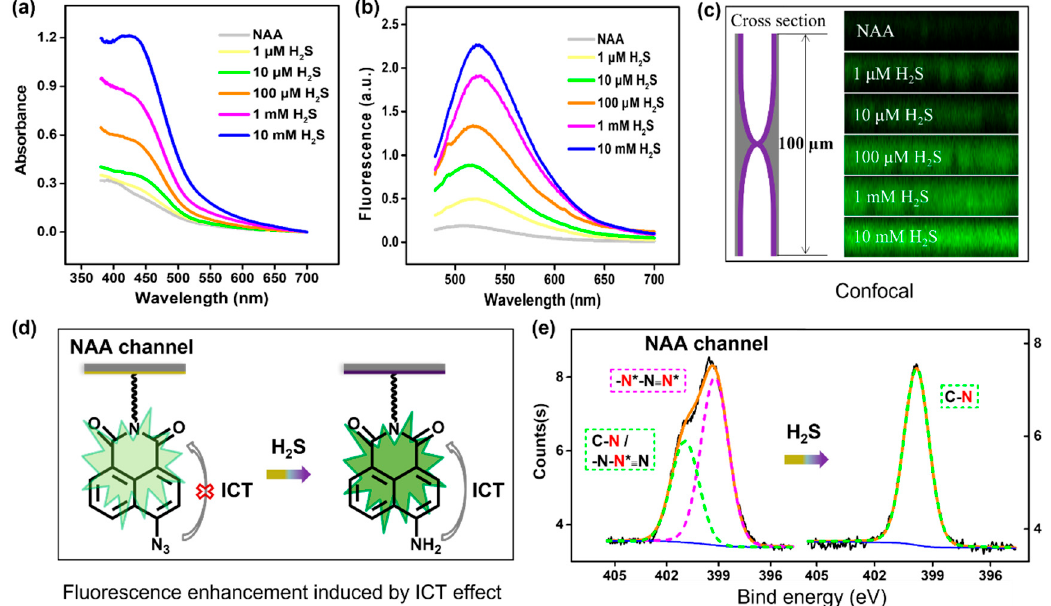
Figure 3. Optical responses of functionalized NAA-modified nanochannels towards H 2 S. ( a ) absorption spectra, ( b ) fluorescence spectra, and ( c ) LSCM images of the nanochannels upon incremental H 2 S concentration. The diagram on the left represents the cross-section of a typical single channel with 100 µm thickness. ( d ) ICT mechanism of NAA probe based on azide reduction by H 2 S. Green fluorescence was recovered upon H 2 S exposure. ( e ) The XPS spectra of nitrogen element of NAA nanochannel membrane before and after H 2 S treatment.